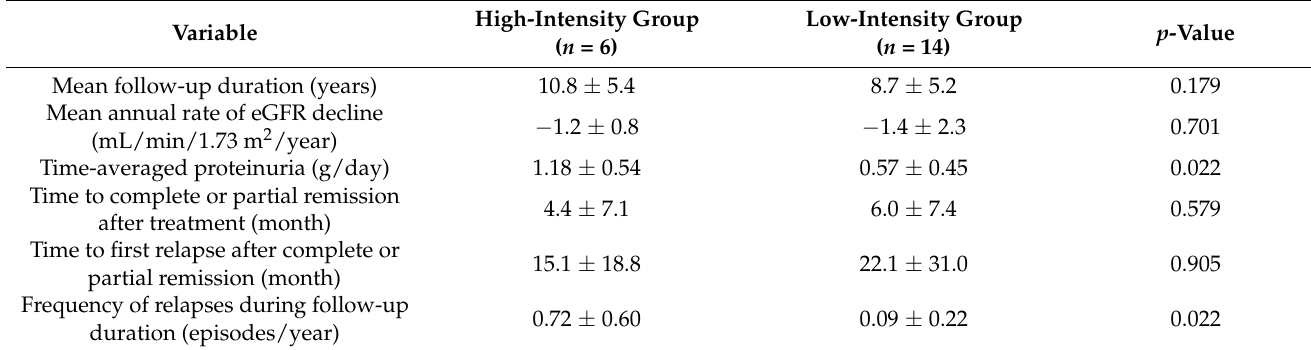
Table 4. Comparison of treatment results between the high and low-intensity